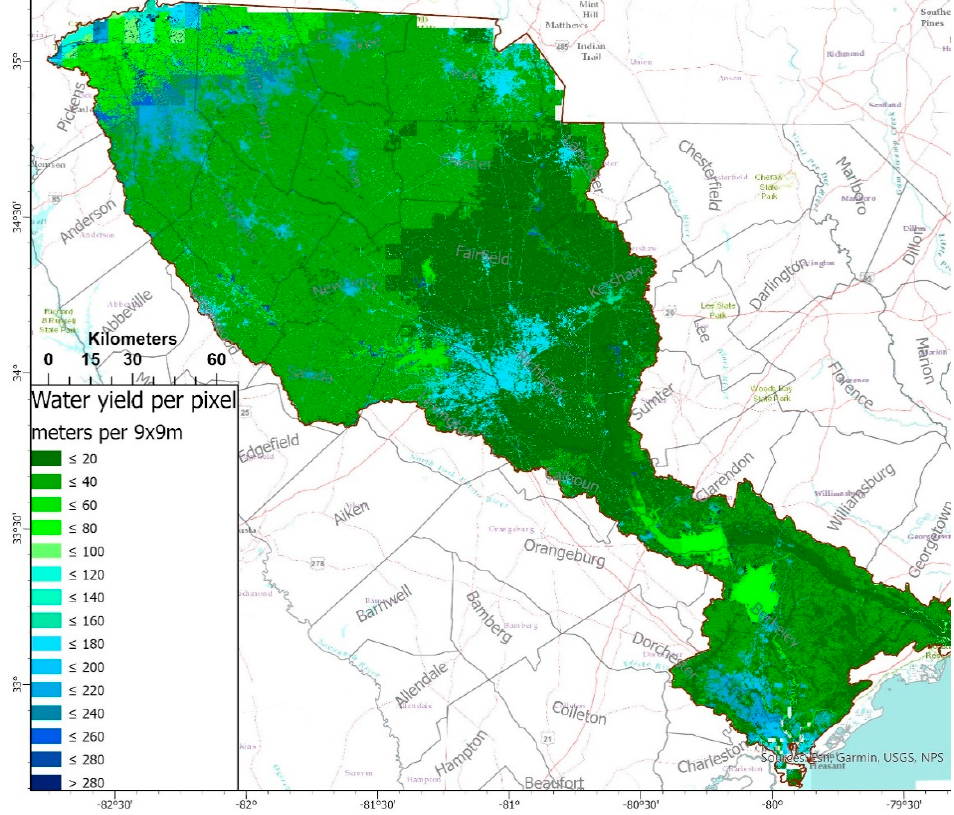
Figure 8. The results of the InVEST WY model showed that the highlighted blue areas have the highest water yield potential per pixel, while the green areas have the lowest.